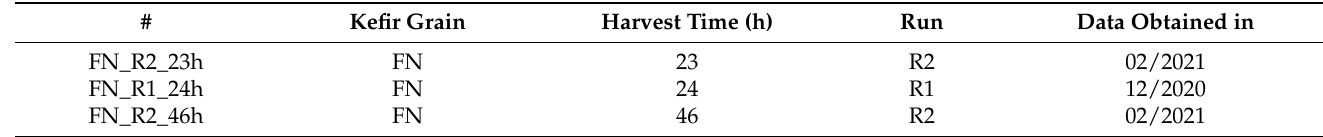
Table A2. Traditional kefir (tk) samples were provided by TU Berlin. Five traditional kefirs (PN1, PN2, PN3, FN, and LS) used in this study were from Berlin, Germany, which have been propagated by three different households. Kefirs FN and LS were originated from PN kefir and were separately propagated for at least three years. Kefirs PN1, PN2, and PN3 were propagated by one household in different batches for at least three